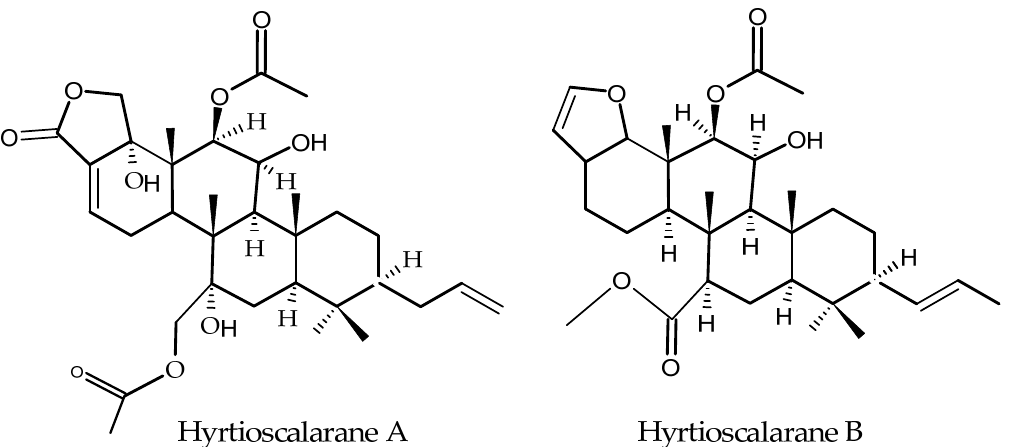
Figure 6. Chemical structure of hyrtioscalaranes A and B, isolated from the demosponge Hyrtios